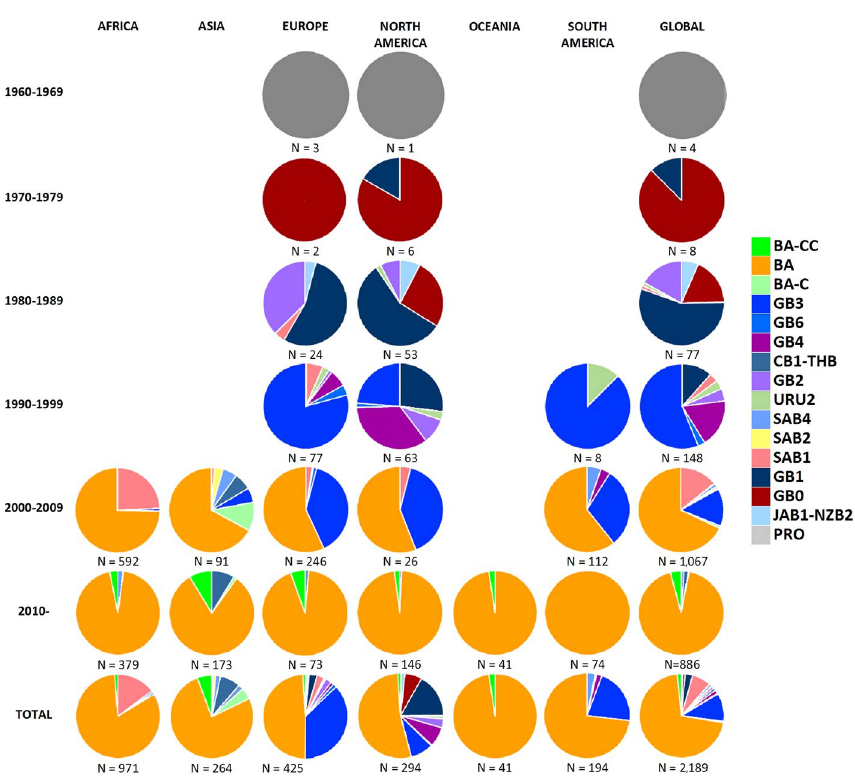
Figure 6. RSV-B genotype distribution since 1960 and each decade thereafter, according to continent of viral